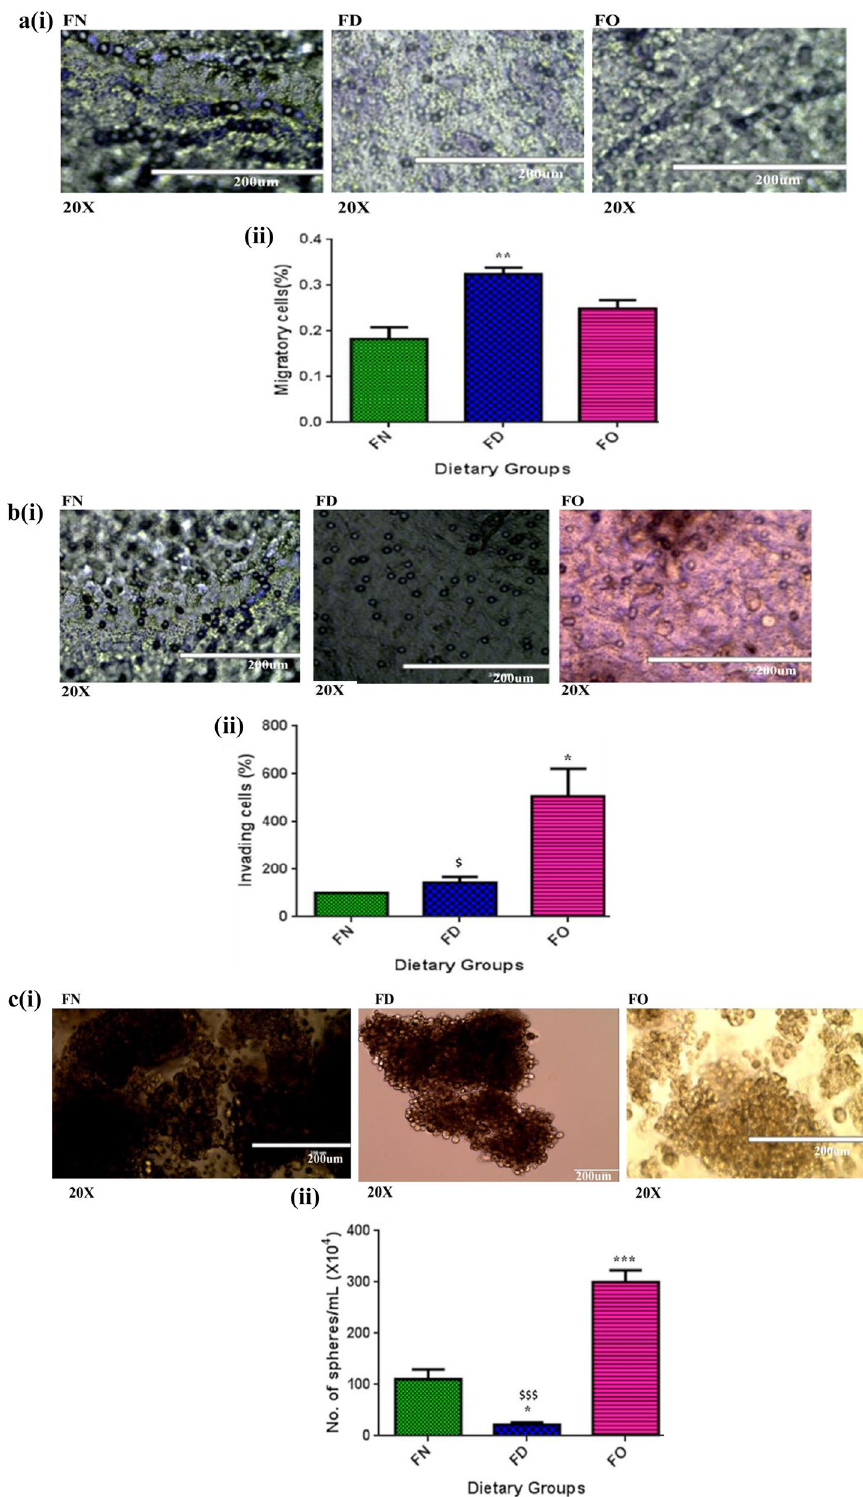
Figure 4. Effect of folic acid deficiency and oversupplementation in HepG2 cells. ( a ( i )) Representative images of migratory cells under microscope under 20× magnification ( a ( ii )) Quantification of migratory cells. ( b ( i )) Representative images of invasive cells under microscope under 20X magnification ( b (ii)) Quantification of invading cells. ( c ( i )) Representative images of spheres under microscope under 20× magnification ( c ( ii )) Quantification of spheres formed. 20X = 200 µm.* P < 0.05, ** P < 0.01, *** P < 0.001 versus FN, $ P < 0.05, $$$ P < 0.001 versus FO; FN-Folic acid normal, FD-Folic acid deficient, FO-Folic acid